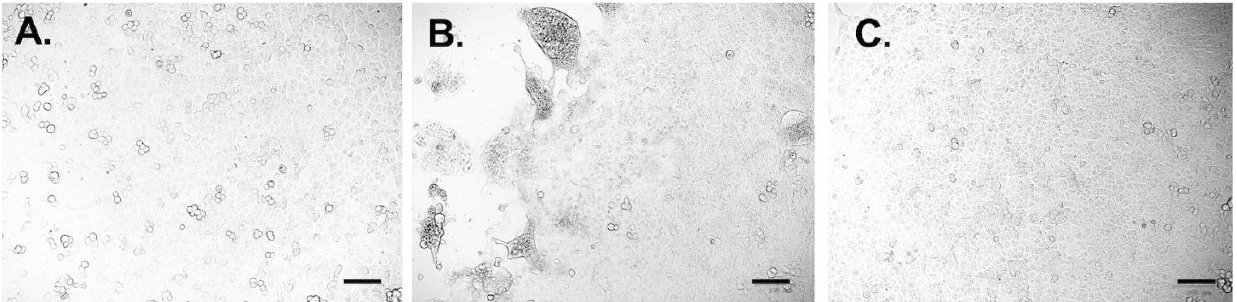
Figure 6. The observation of cytopathic effects (CPEs) in the neutralization test. The recombinant scFv was incubated with 400 TCID 50 /mL PEDV-PT-passage 5 for 2 h and subjected to the Vero cells. The CPE was observed every 24 h and the images were taken at the end time point, 72 h. ( A ) The group was supplemented with 25 μg/mL scFv and virus. ( B ) The challenge control group (virus without the scFv). ( C ) The non-challenged control group (no virus, no scFv). The black bars represented 100 μm in length. Table 3. The neutralizing ability of recombinant scFv against the G2b PEDV.